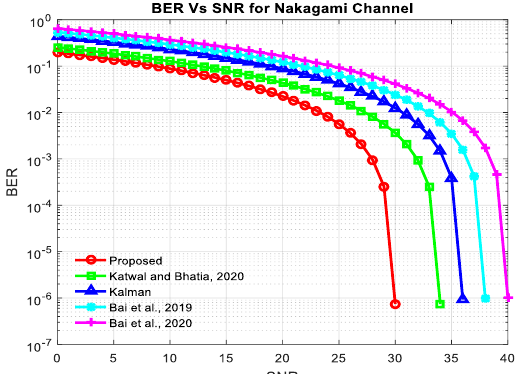
Figure 14. BER vs. SNR analysis for Nakagami